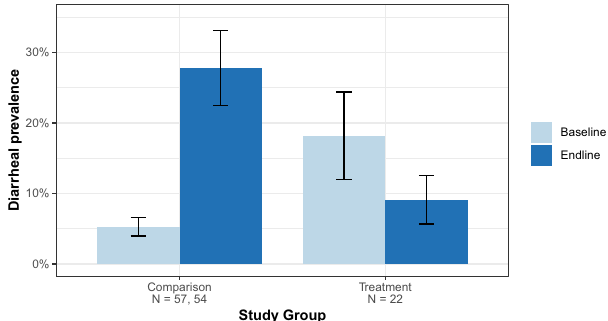
Fig. 4 Self-reported diarrheal prevalence. Seven-day prevalence of caregiver-reported clinical diarrhea in under-5 children, by study phase and